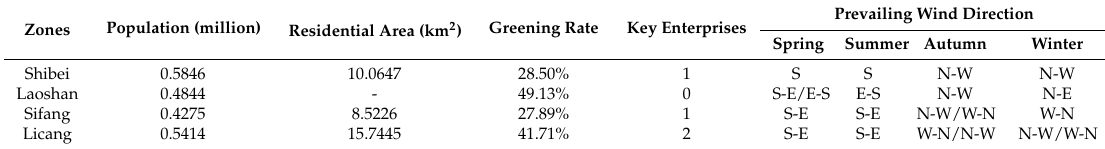
Table 1. Statistical information of related conditions in the four zones.